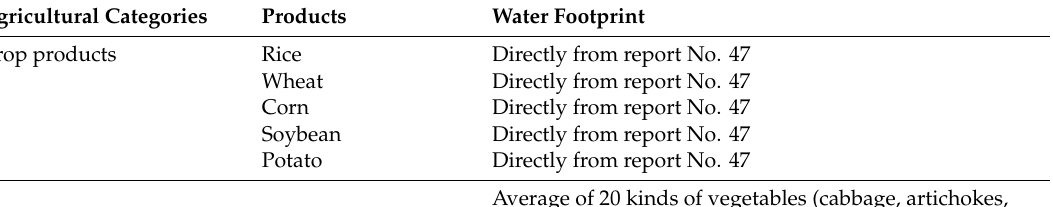
Table 1. Data explanation of water footprint per unit of food